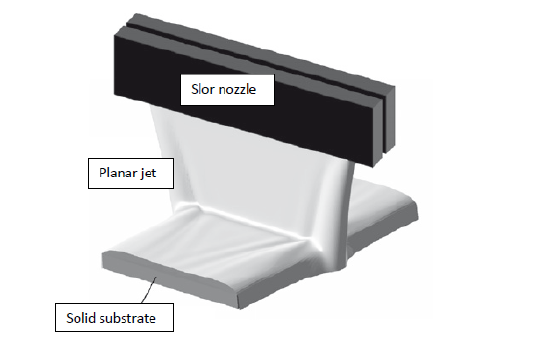
Fig. 1. Schematic diagram of a planar jet impinging on a solid sur-